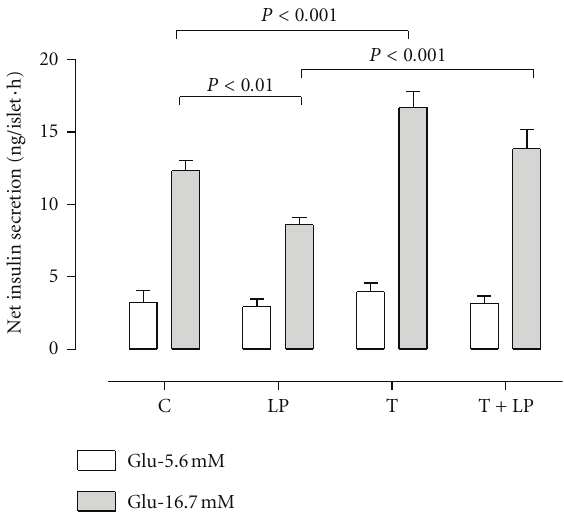
Figure 2: Glucose-induced insulin secretion in islets from rats submitted to a protocol of physical training four weeks before gestation and during gestation. During gestation, duration and intensity of each session of physical exercise were progressively reduced and each group received either 17% casein diet (C and T) or 8% casein (low-protein group, LP and LP + T) isocaloric diet ad libitum . Groups of five islets were initially incubated for 45min at 37 ◦ C in Krebs-bicarbonate bu ff er containing 5.6mM glucose. The solution was then replaced with fresh Krebs-bicarbonate bu ff er and islets were incubated for a further 1h with medium containing 5.6 or 16.7mM glucose. The values are presented as means ± S.E.M. ∗ P < 0.05 versus C group using two-way ANOVA and Bonferroni’s post-hoc